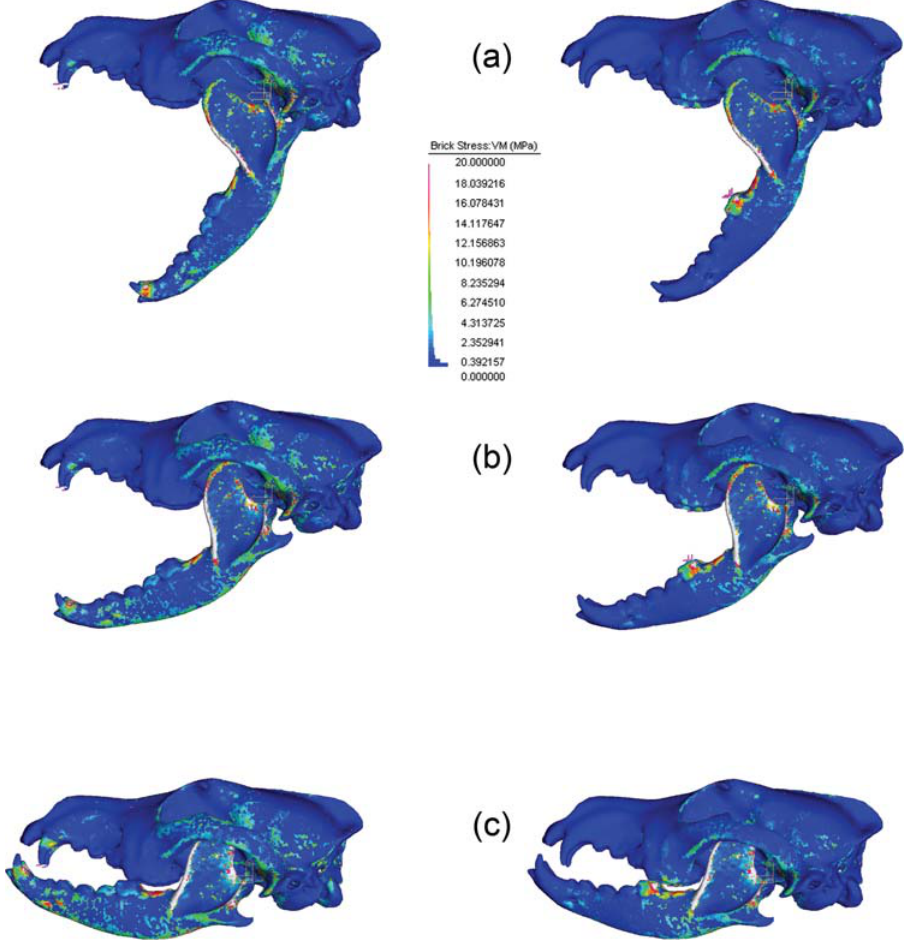
Figure 3. Comparison of stress development in C.l.dingo during bites directed at the canines (left), or carnassials (right) at select angles to show trend. Gape angles are (a) 65 u , (b) 35 u and (c) 05 u .